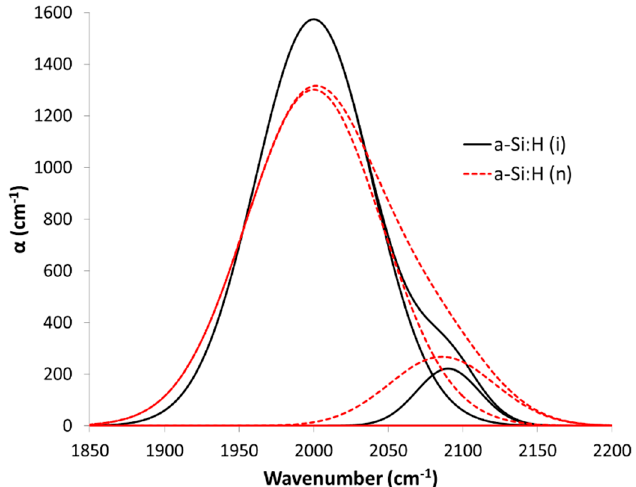
Figure 5. Deconvolution of the FTIR spectra band at 1850-2200 cm − 1 of the a-Si:H(i) film grown at 200 °C and the n-doped a-Si:H film grown at 250 °C, both growing by PECVD, to compare the difference of contribution in the bands centered near 2000 cm − 1 and near 2100 cm − 1 .